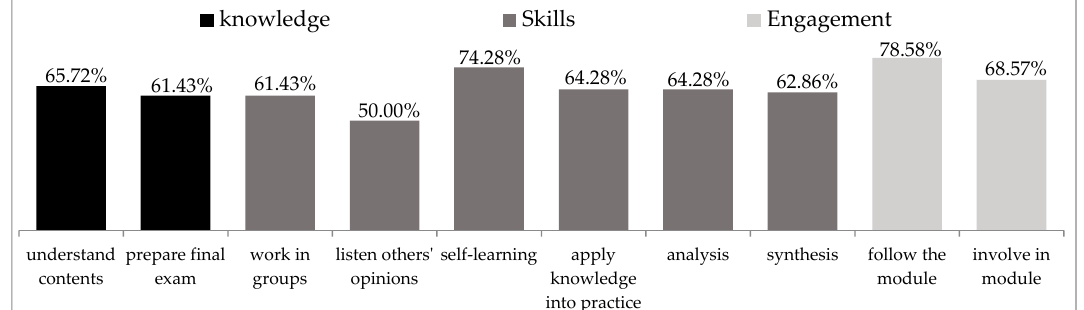
Figure 1. Impact of flipped learning on knowledge, skills and engagement.